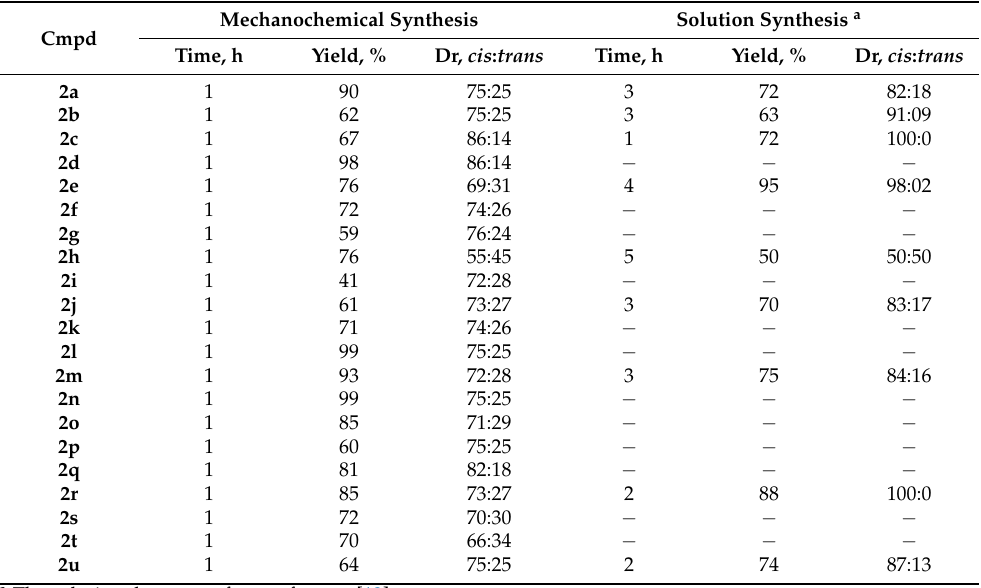
Table 2. Comparison of the results of synthesis of 1,2,3,4-tetrahydroquinoline and 1,2,3,4-tetrahydro- 1,5-naphthyridine derivatives 2 under mechanochemical and conventional